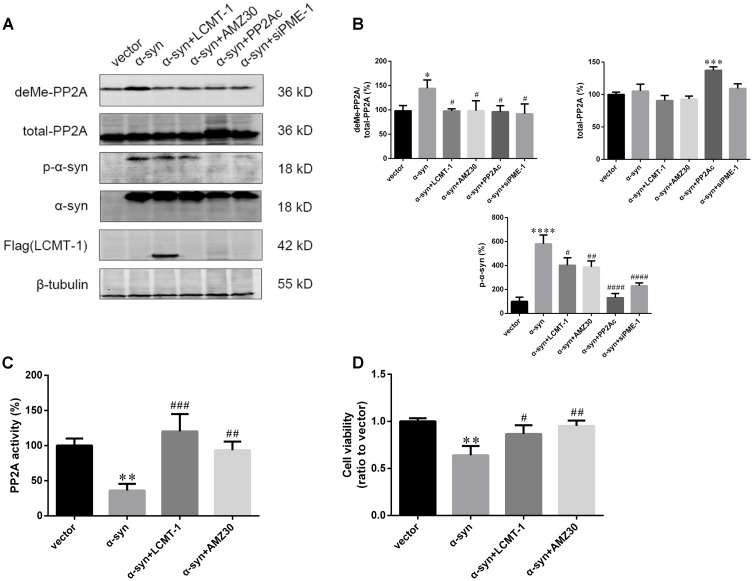
LCMT-1 overexpression or PME-1 inhibition by AMZ30 protected against PP2A inactivation and cell apoptosis mediated by α-syn. (A,B) Immunoblotting and quantifications of deMe-PP2A, total-PP2A, p-α-syn, α-syn, and Flag-LCMT-1 in vector, α-syn, α-syn + LCMT-1, α-syn + AMZ30, α-syn + PP2Ac, and α-syn + siPME-1 group. β-tubulin was used as a loading control. The ratio of deMe-PP2A to total-PP2A, total-PP2A to β-tubulin, p-α-syn to β-tubulin in vector group was individually considered as 100%. (C) Histogram showing the PP2A activity in the aforementioned groups. (D) Cell viability was measured with CCK-8. Data are expressed as mean ± SD. KS test; P > 0.05; Brown–Forsythe test; P > 0.05; one-way analysis of variance; ∗P < 0.05, ∗∗P < 0.01, ∗∗∗P < 0.01, ∗∗∗∗P < 0.0001 vs. vector (n = 3); #P < 0.05, ##P < 0.01, ###P < 0.001, ####P < 0.0001 vs. α-syn (n = 3).